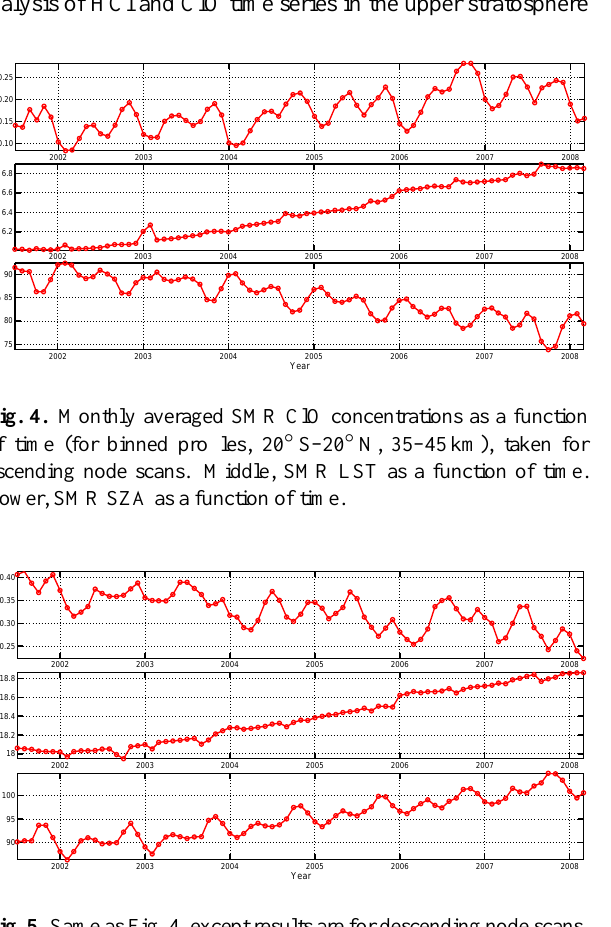
Fig. 5. Same as Fig. 4, except results are for descending node